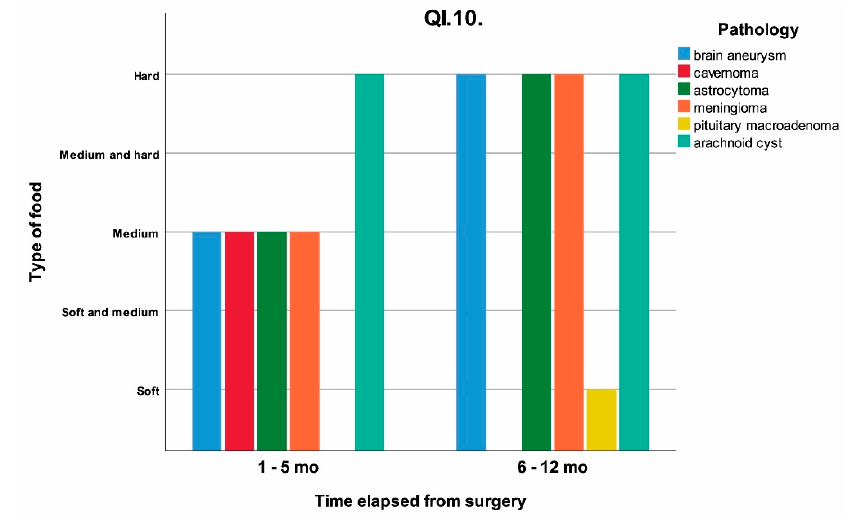
Figure 3. The response at QI.4 (“Did you experience, during/after the healing period, any pain in the anterior region of the ear?”) influenced by the time elapsed from surgery clustered on the initial pathology; mo = months.